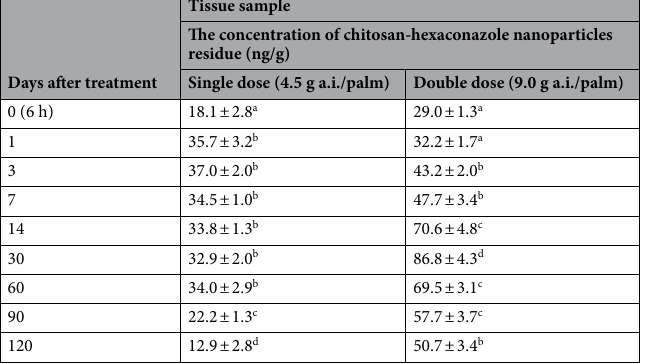
Table 5. The accumulation of chitosan-hexaconazole nanoparticles residue found on tissue, where different letters in the same column indicate significant differences between means (p ≤ 0.05) according to Tukey’s test. ND not detected.